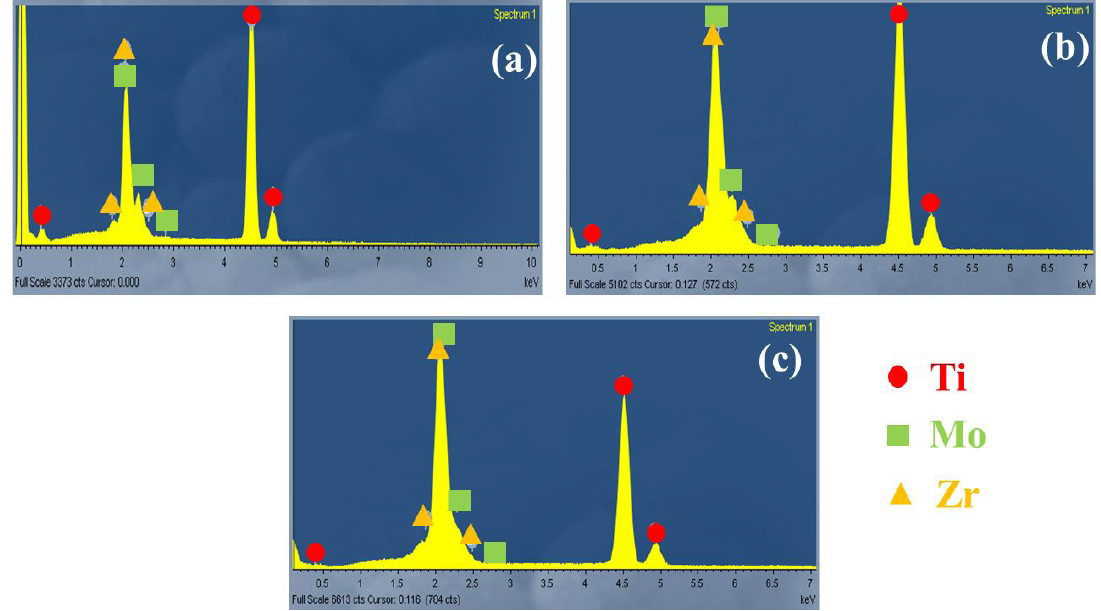
Figure 1. EDS spectra for Ti-10Mo-30Zr (a), Ti-10Mo-40Zr (b) and Ti-10Mo-50Zr (c)